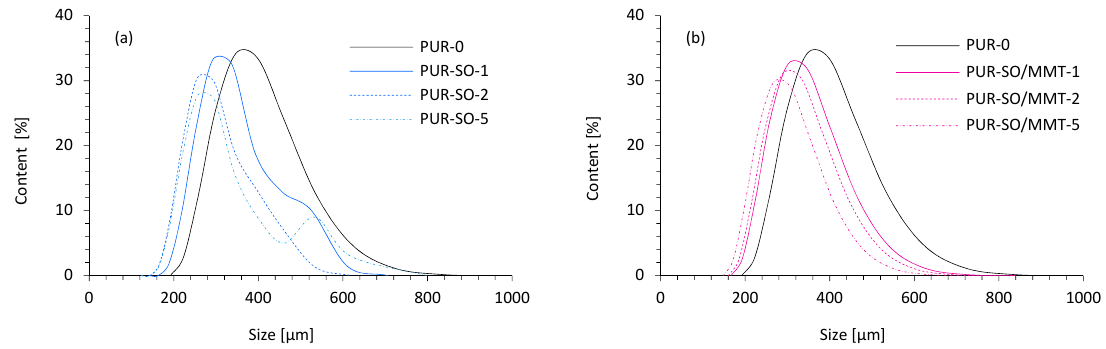
Figure 8. The cell size distribution of PUR composites reinforced with ( a ) unmodified SO filler, and ( b ) MMT-modified SO filler.